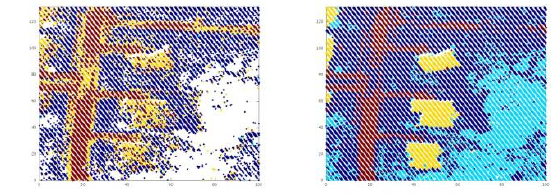
Figure 11: Change in the classification result caused by using range differences and adding multi-echo waveforms